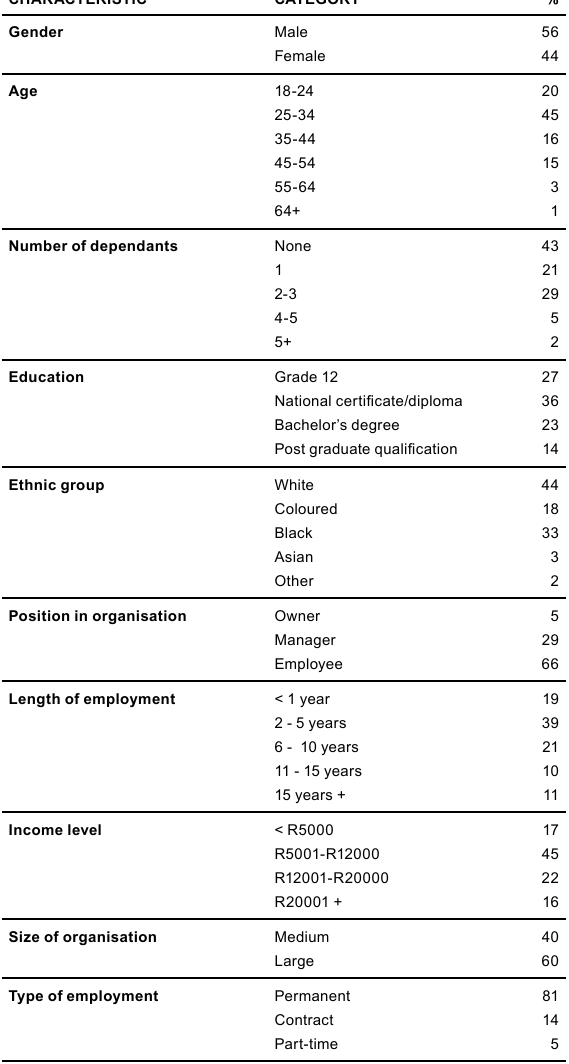
Table 3 Frequency distribution results of classification dataptions